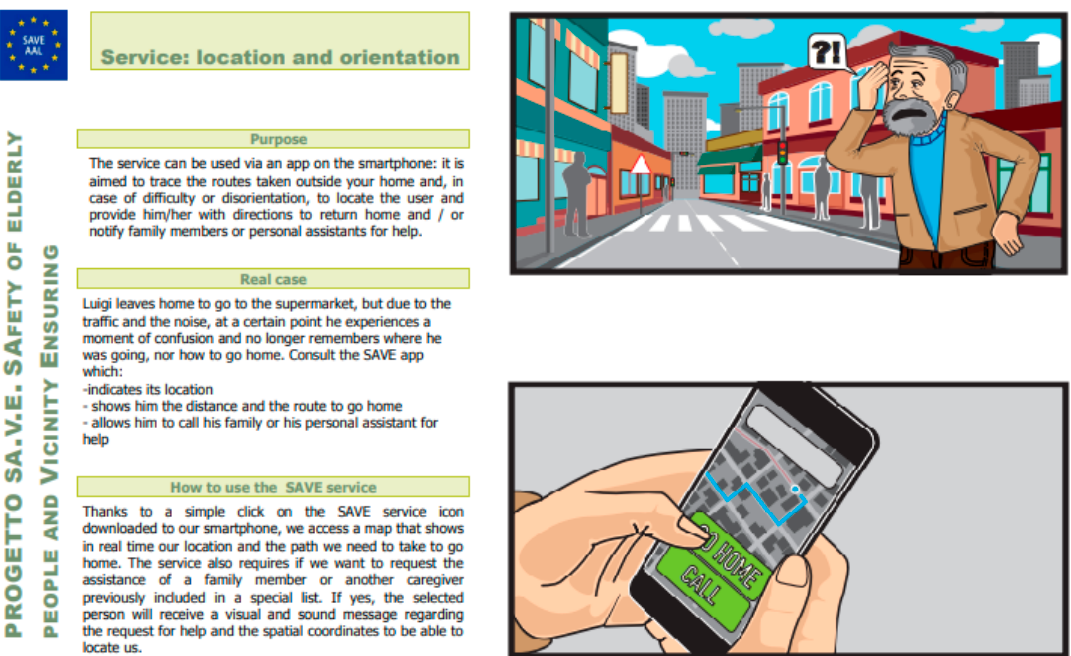
Figure 2. An example of a storyboard checked by stakeholders prior to the focus group’s engagement. The storyboard shows how the user would interact with the SAVE system.